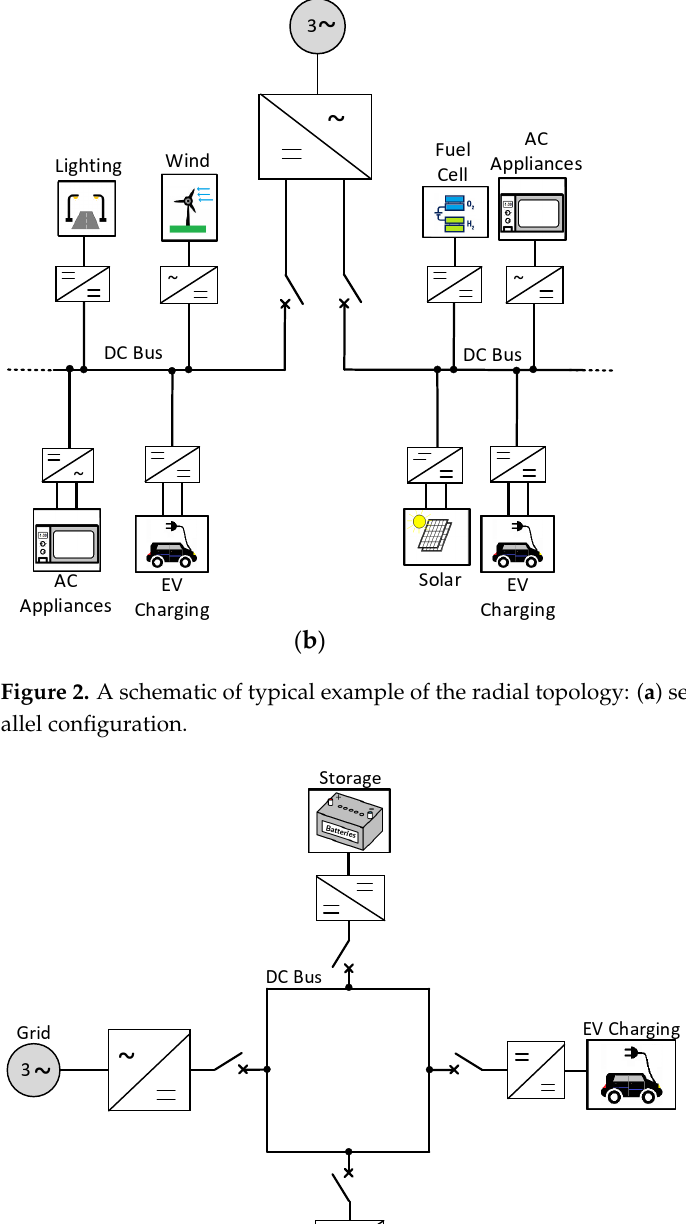
Figure 3. A schematic of typical example of the ring topology.